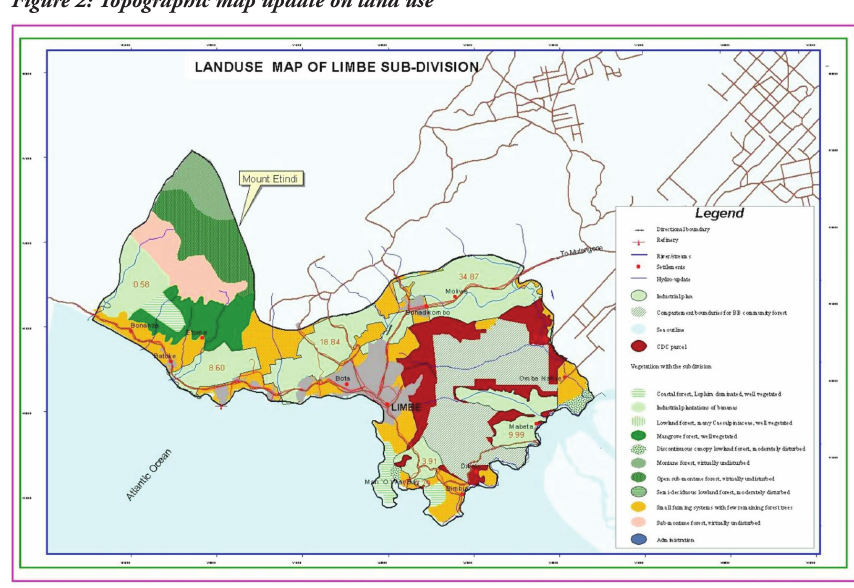
Figure 2: Topographic map update on land